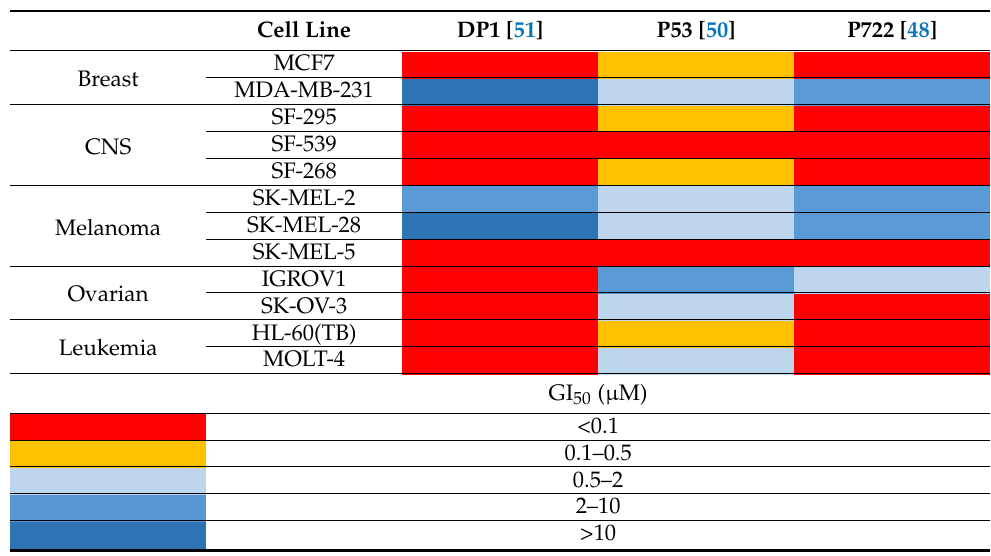
Table 3. GI 50 values in µ M on some cancer cell lines (breast, central nervous system (CNS) cancer, melanoma, ovarian cancer and leukemia) of the DP1, P53 and P722